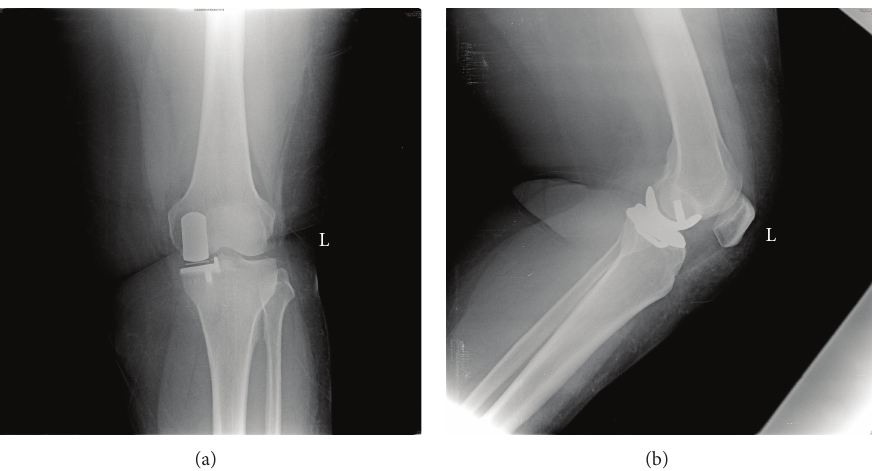
Figure 1: (a) A 56-year-old female patient that underwent cemented Oxford UKA, anterior-posterior view. (b) Lateral view.